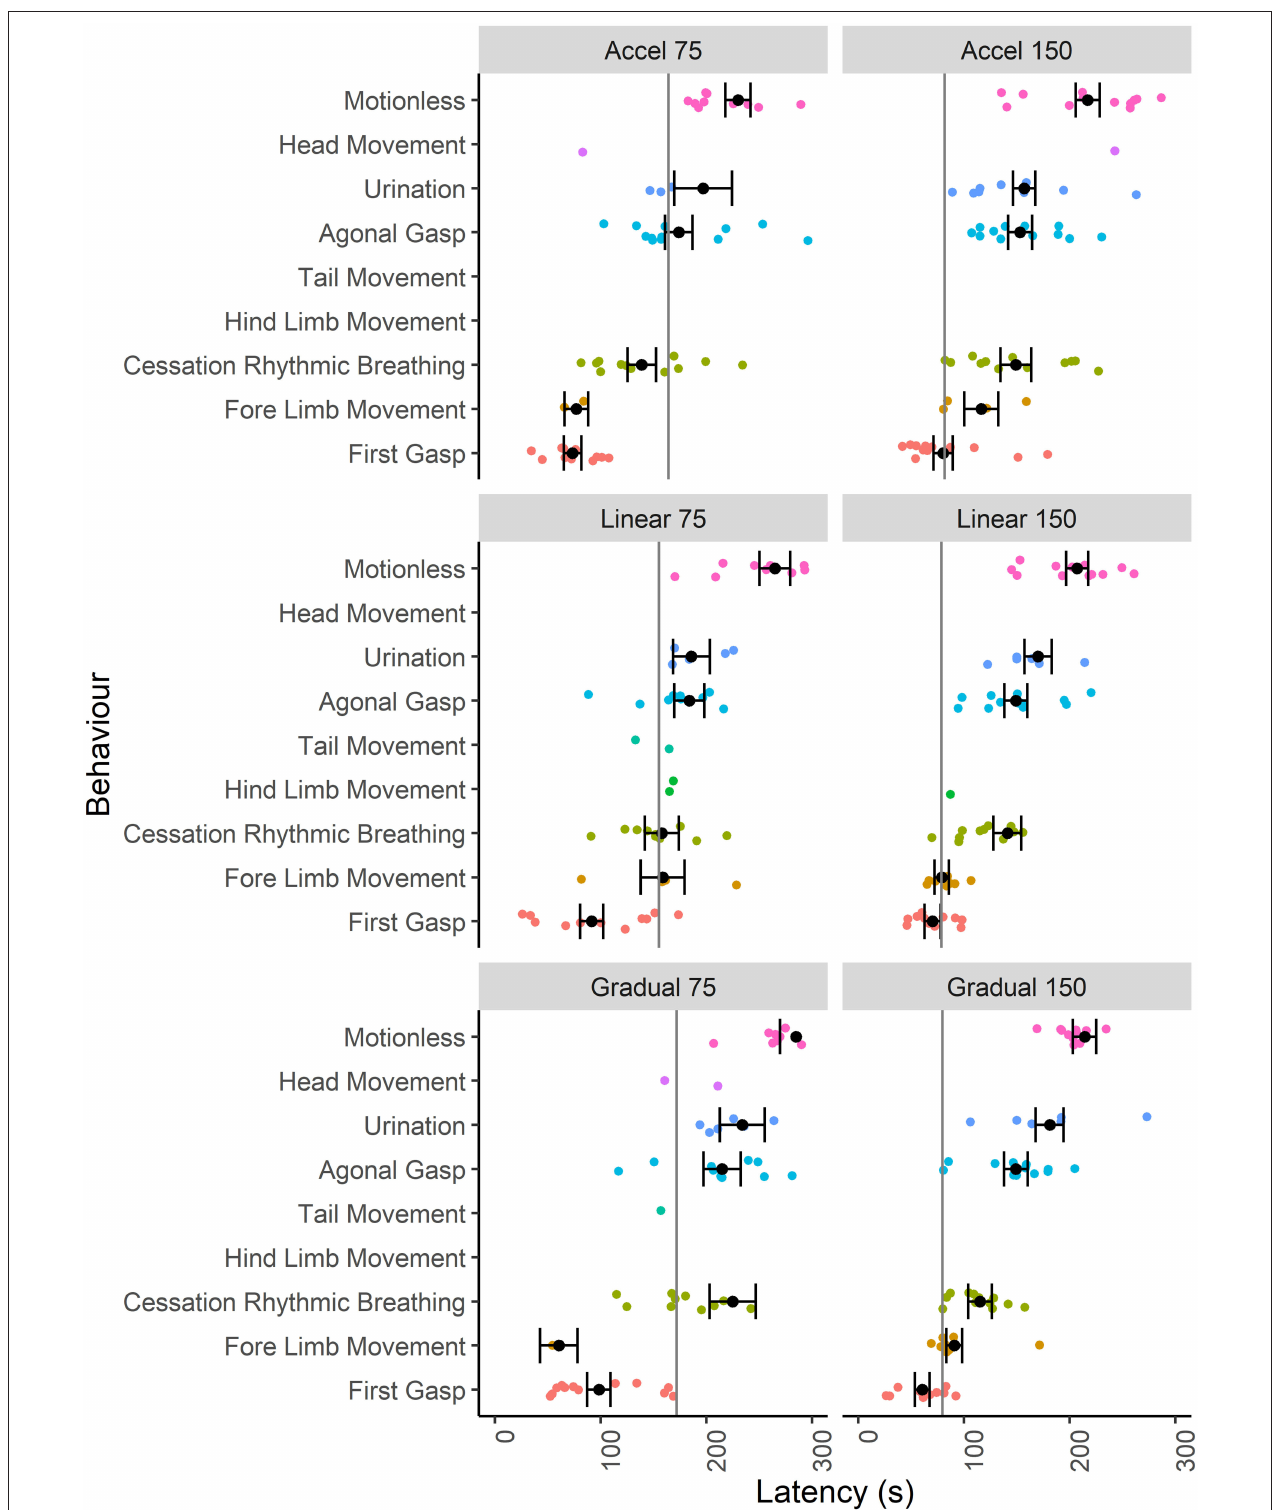
FIGURE 2 | Individual data points and mean ( ± SE) latencies (s) of key reflexive behaviors relating to respiratory responses (e.g., gasp) and non-recovery indicators (e.g., motionless) observed across the six candidate decompression profiles according to both rate (75 and 150 ms − 1 ) and shape [Accelerated (Accel), Linear and Gradual, n = 12 per profile, n = 13 linear 150 ms − 1 , n = 11 linear 75 ms − 1 ]. The vertical gray lines represent mean latencies to reach 200 mBar and the start of the Phase 2 hold period for each decompression profile.